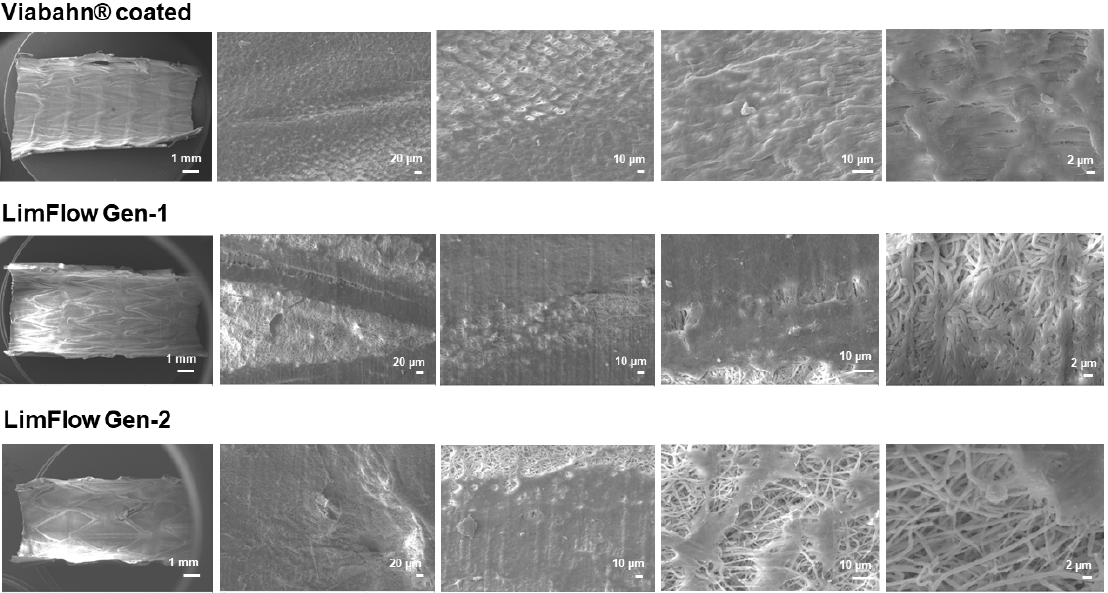
Figure 10. Analysis of the blood-contacting surface of stent grafts using SEM. Detection of the thrombogenicity in experiment series C. Representative images from one donor are shown after the blood contact ( n = 8).